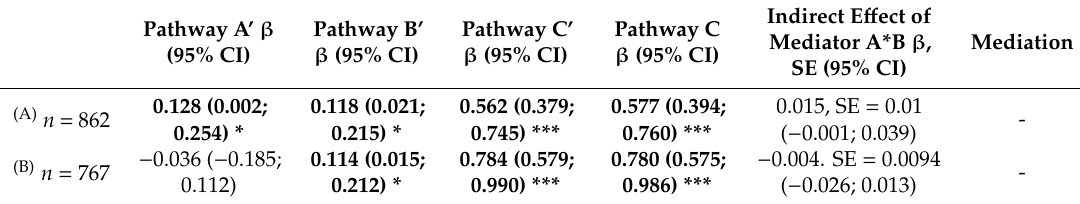
(A) Unadjusted simple mediation analysis, (B) Simple mediation analysis adjusted by birth weight, gestational age at birth, maternal education, maternal and paternal BMI at child’s birth, ethnicity, and maternal smoking during pregnancy. Pathway A’: Association between RWG and infant feeding practice. Pathway B’: Association between infant feeding practice and BAz at 6 years. Pathway C’: Direct association of RWG and BAz after adjustment for mediator (infant feeding practice). Pathway C: The total e ff ect (c) shows the association between RWG in the 1st semester of life and BAz at 6 years. A*B: Indirect e ff ect of the infant feeding practice on the association